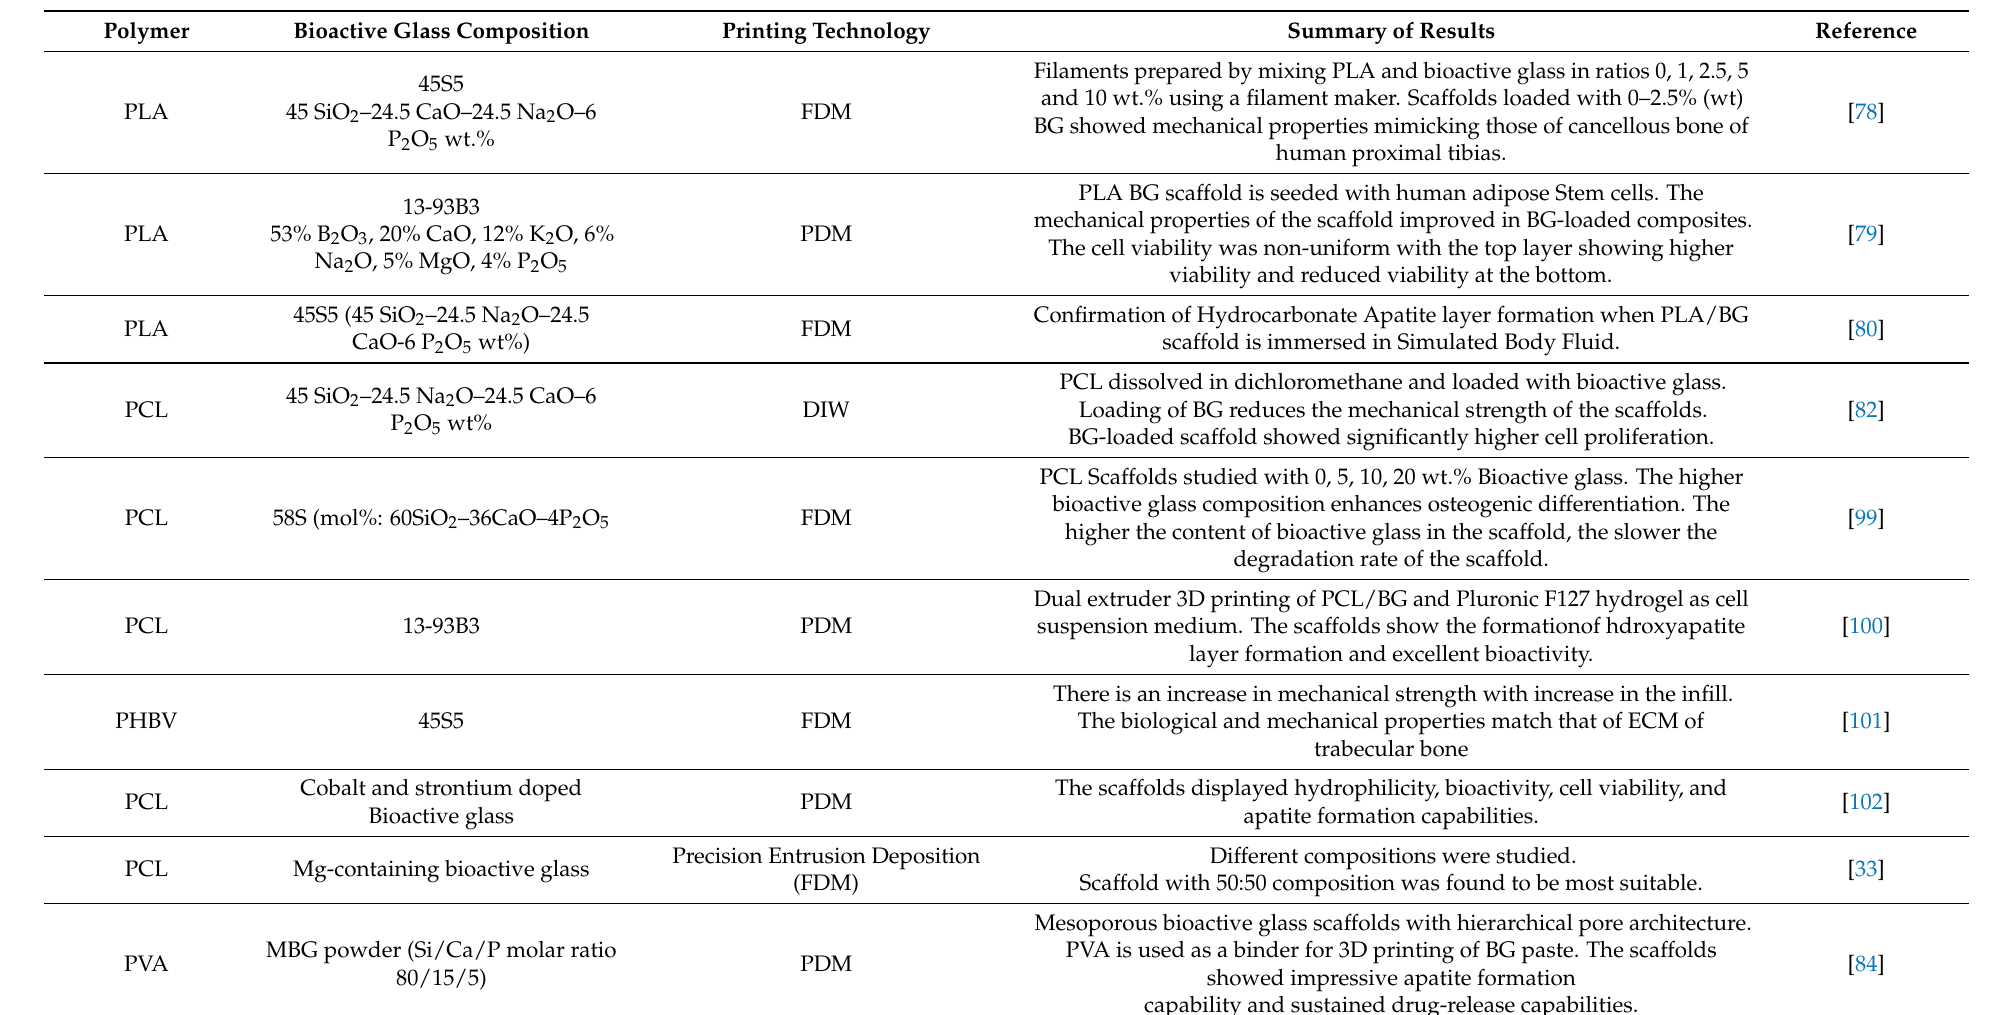
Table 2. Summary of results for studies in 3D-printed synthetic-polymer bioactive glass